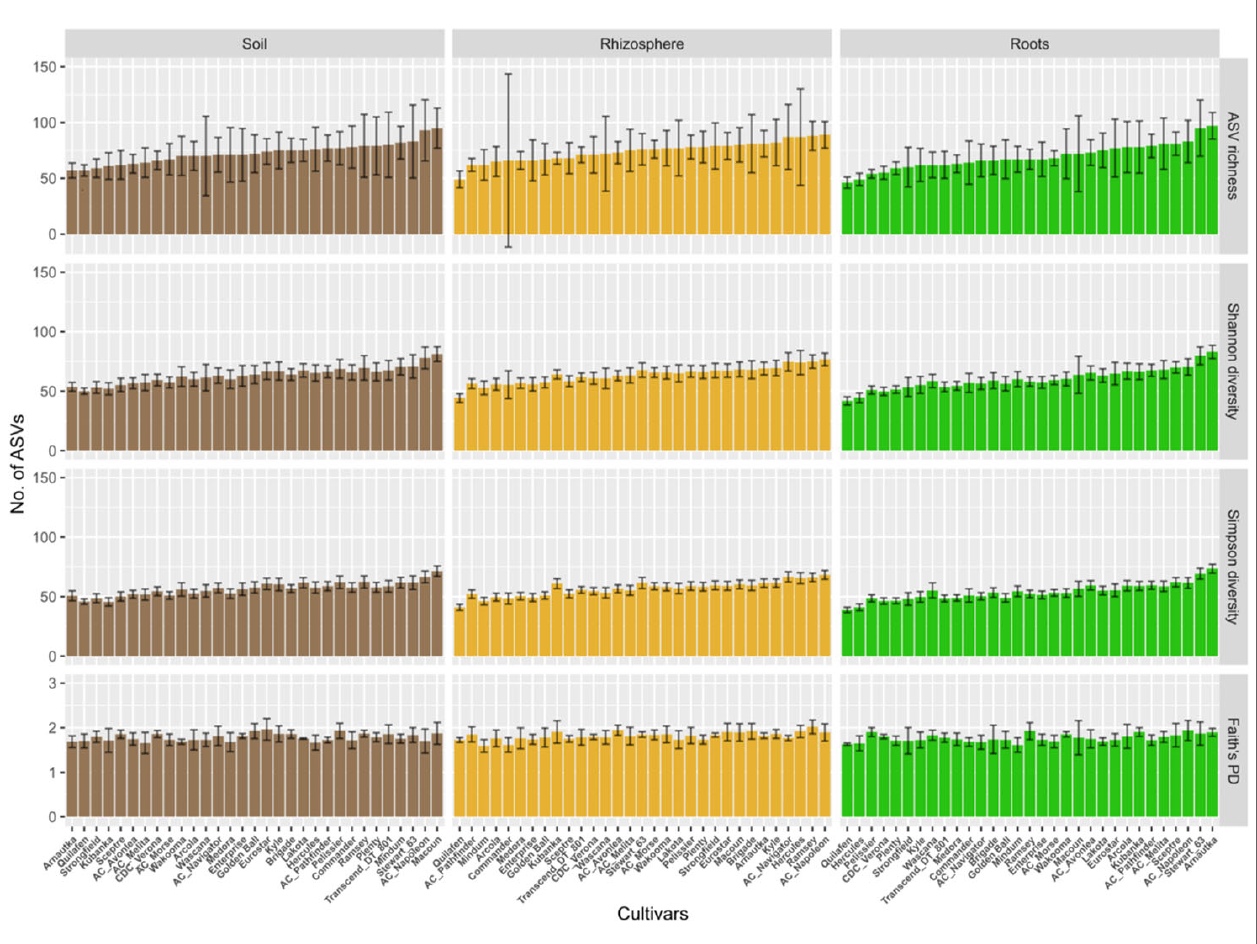
FIGURE 3 | Diversity measured in soil, rhizosphere and root samples for each of the fi ve landraces and 26 durum wheat cultivars. The ordinate displays Hill numbers of three orders: ASV richness (q = 0), Shannon diversity (q = 1), and Simpson diversity (q = 2), and Faith ’ s Phylogenetic diversity. Cultivars are sorted according to the mean ASV richness observed in root samples, from the lowest to the highest. Error bars represent estimated bootstrap standard